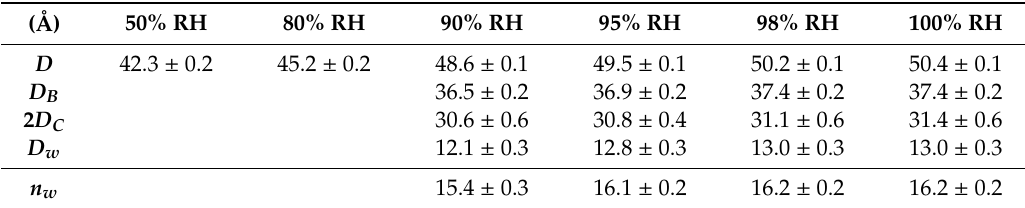
Table 1. Structural parameters from DoPhPC:DoPHPE (9:1) obtained by neutron di ff raction as a function of relative humidity. The samples were hydrated with 8% D 2 O. In case of 50% and 80% RH, it was not possible to extract all parameters as the membranes were not su ffi ciently structured to yield enough Bragg